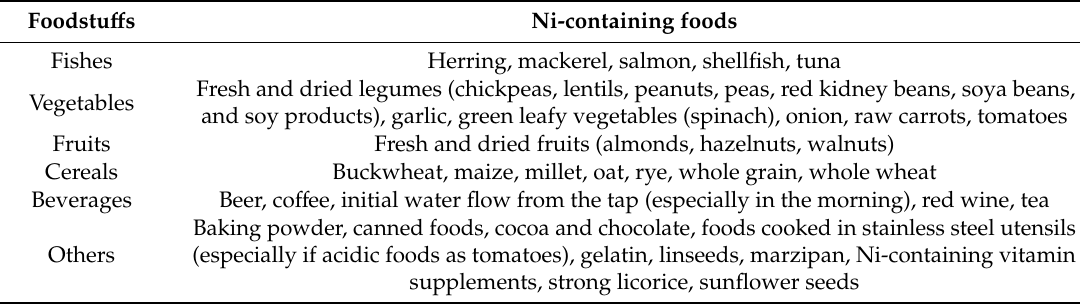
Table 1. Foods that contain a high amount of nickel